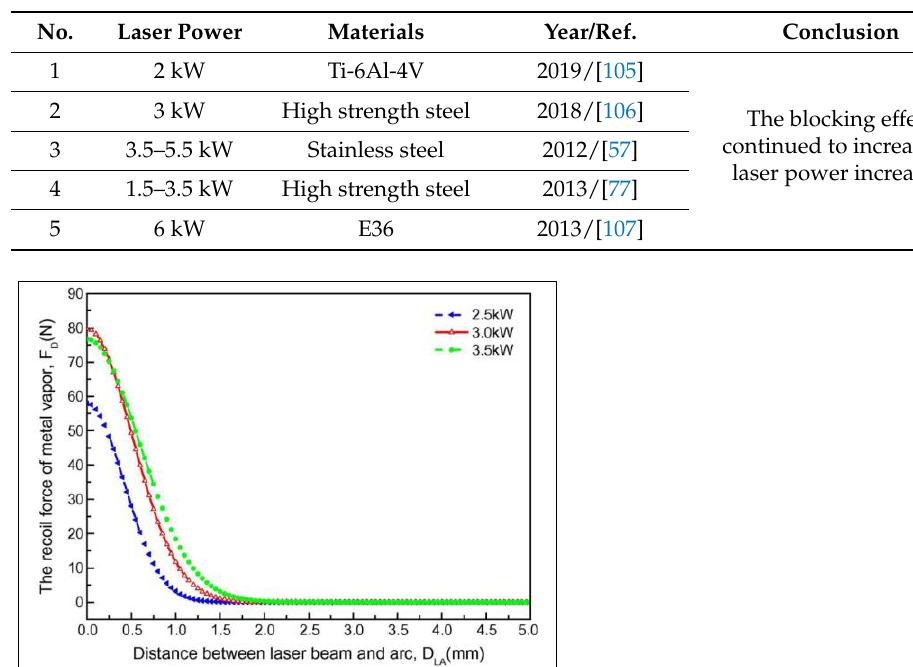
Table 5. The relation of laser power and blocking effect in this review.